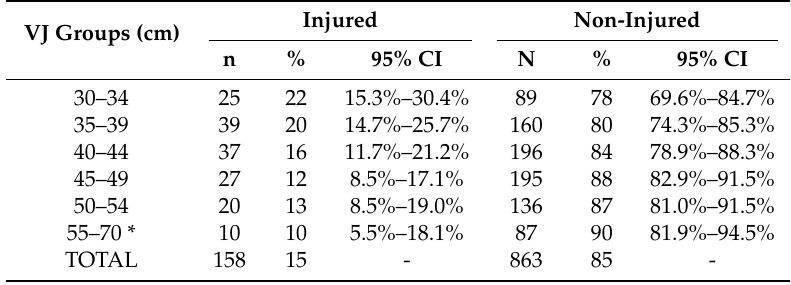
Table 1. Vertical jump score comparison of the injured and non-injured participants.